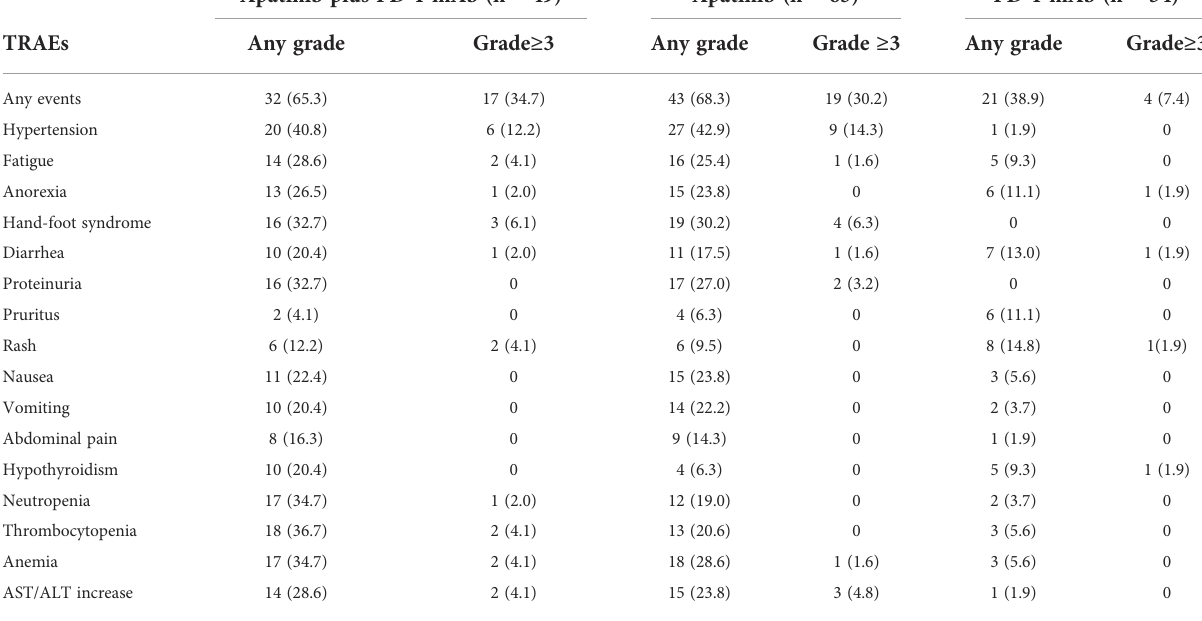
TABLE 5 Treatment-related toxicities (n